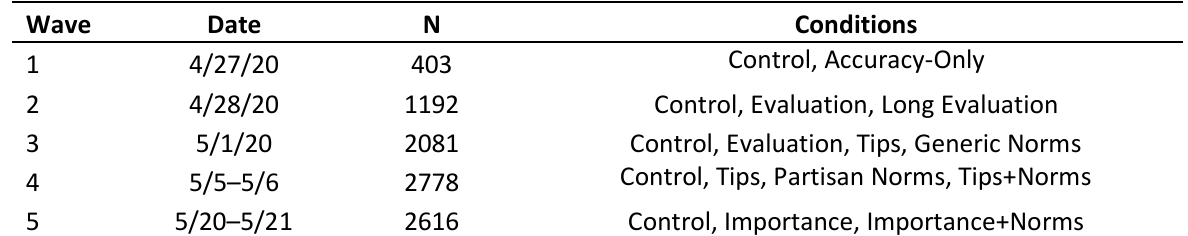
Table 1. Details of the five waves of data collection. Sharing discernment in the control did not differ significantly across waves.